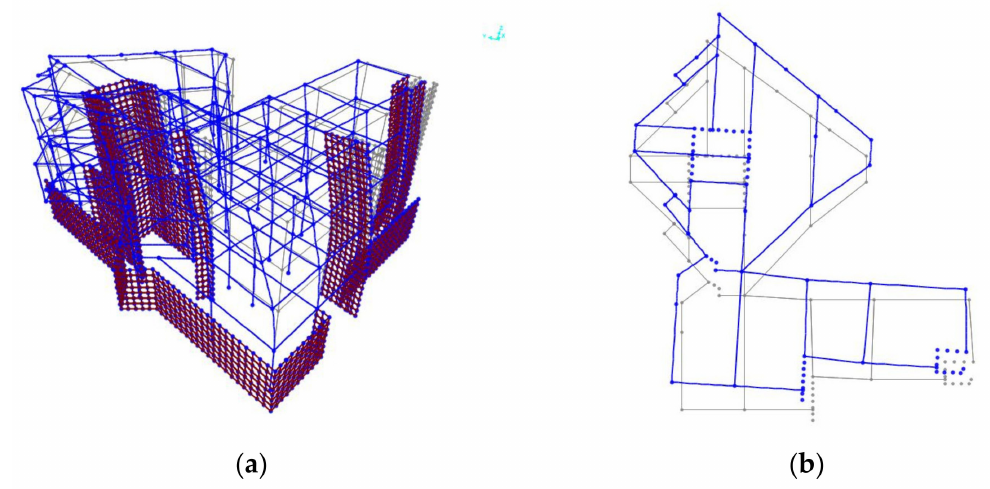
Figure 18. Third mode is a torsional-bending mode along y axis with frequency equal to 8.44 Hz (in grey the un-deformed configuration and in blue the mode shape): ( a ) 3D view; ( b ) plan